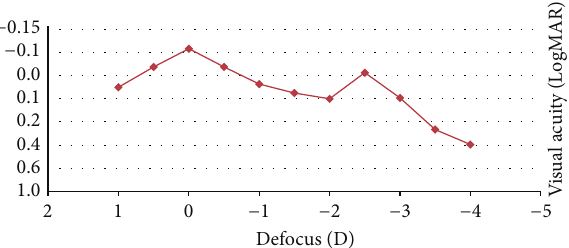
Figure 4: Mean binocular defocus curve at 3 months after surgery in the analysed